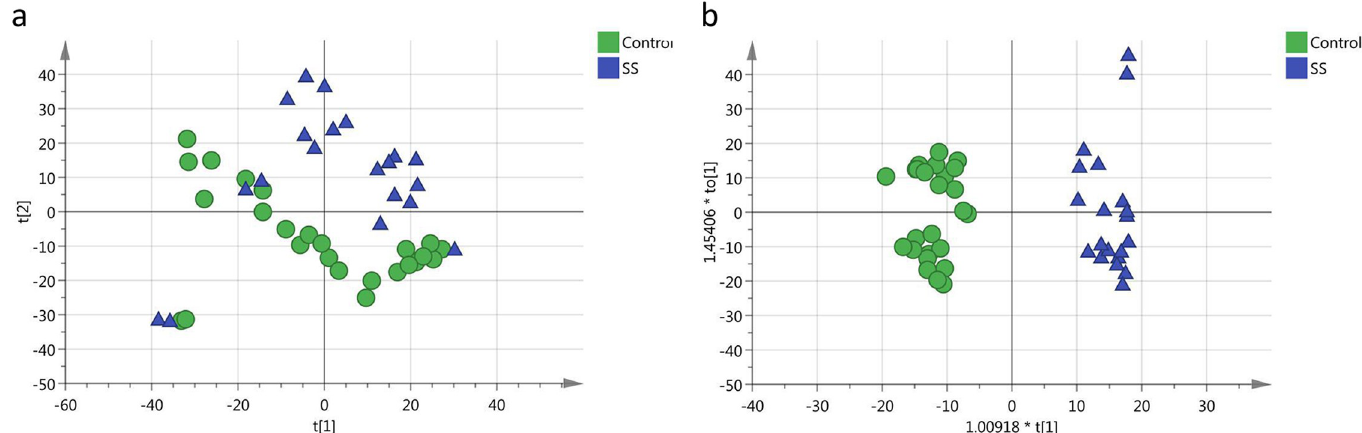
Fig 2. Comparison between pSS subjects and healthy controls. (a) Score plot of the PCA-X model between pSS subjects (blue) and healthy controls (green). (b) Score plot of the OPLS-DA model between pSS subjects (blue) and healthy controls (green).